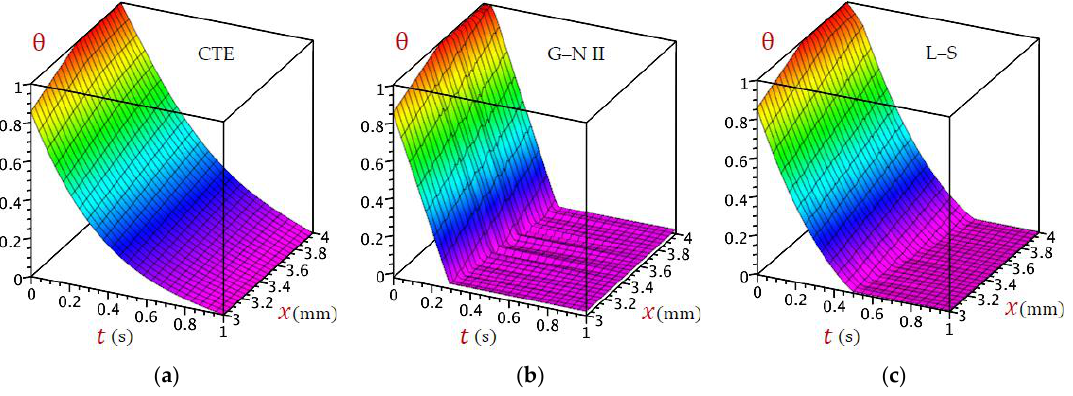
Figure 15. Three-dimensional distributions of temperature (𝜃) for ( a ) CTE, ( b ) G – N II, and ( c ) L – S models.